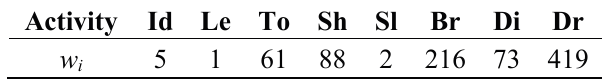
Table 3. Selection of the weights w i using TK26M dataset.